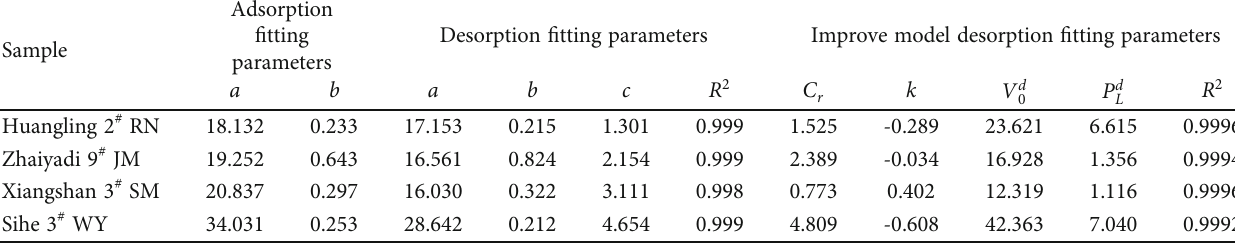
Table 1: Comparison table of four groups of experimental data fi tting parameters.